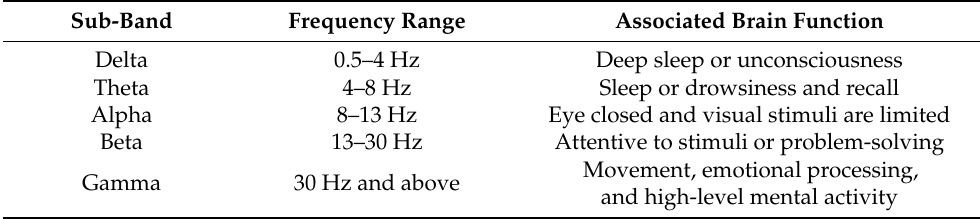
Table 1. EEG sub-bands are associated with different brain functions